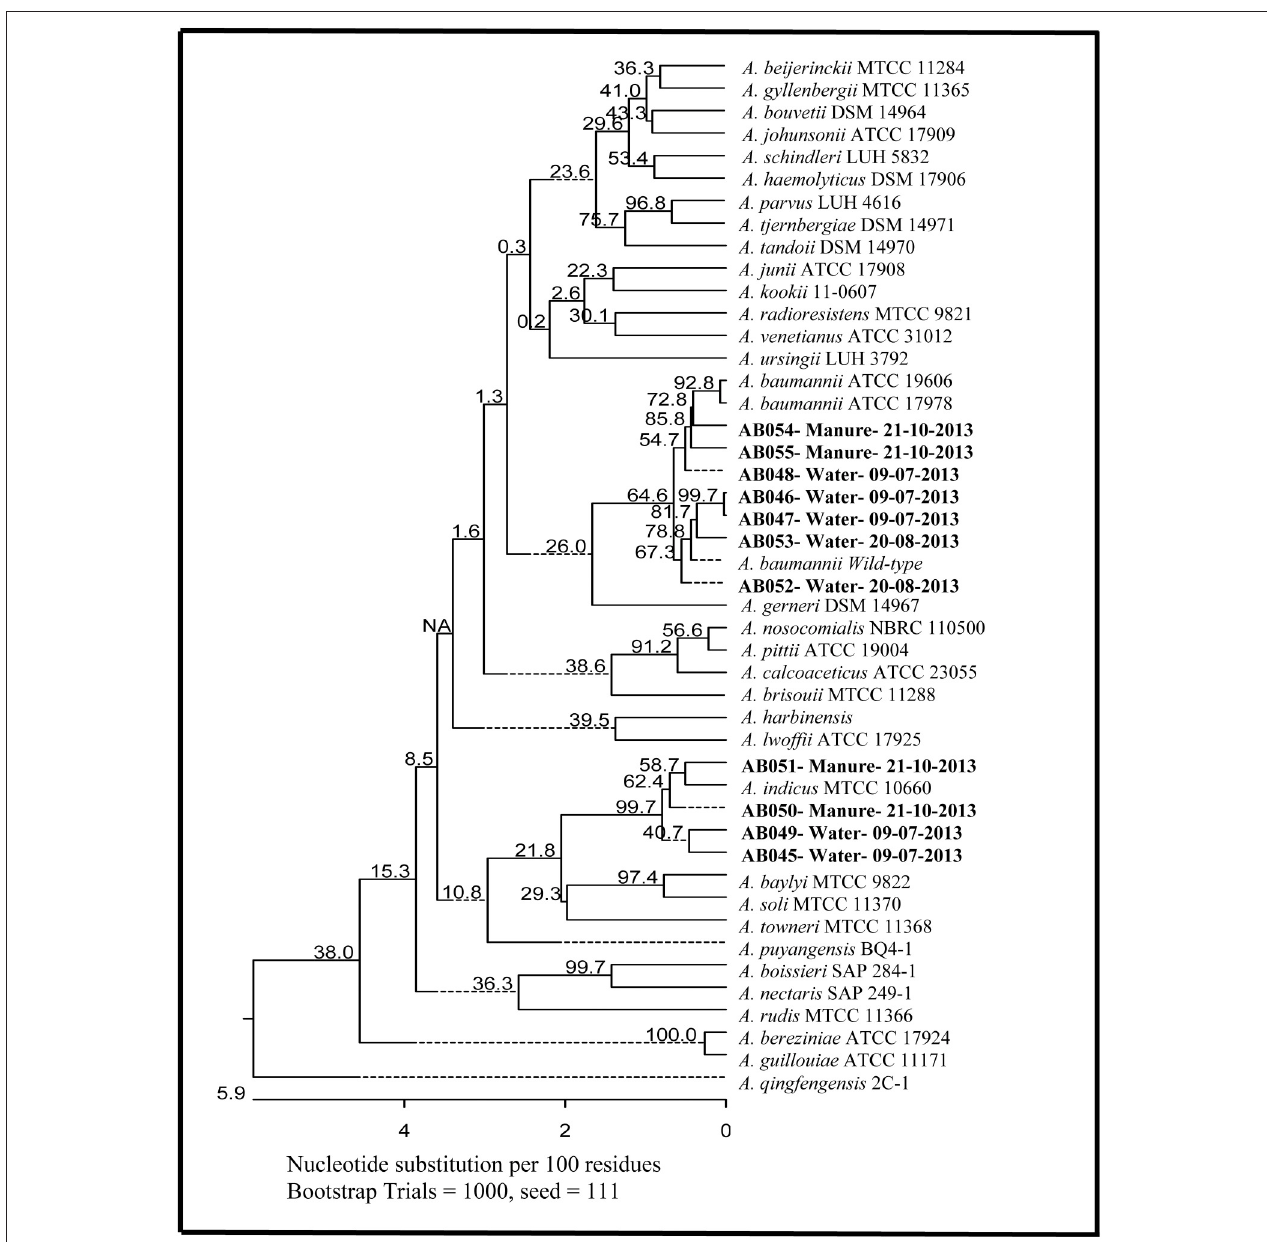
FIGURE 1 | Phylogenetic tree based on gene encoding 16S rRNA sequences (833 bp) showing the phylogenetic similarity of Acinetobacter strains isolated from agricultural water and dairy cattle manure samples with other Acinetobacter spp. Bootstrap values based on 1000 replications are shown at the nodes of the tree. The scale bar represents 5.9% nucleotide sequence